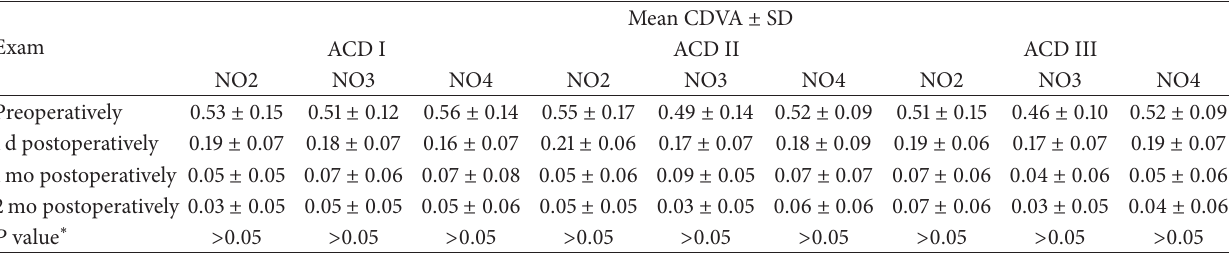
Table 3: Preoperative and postoperative logMAR